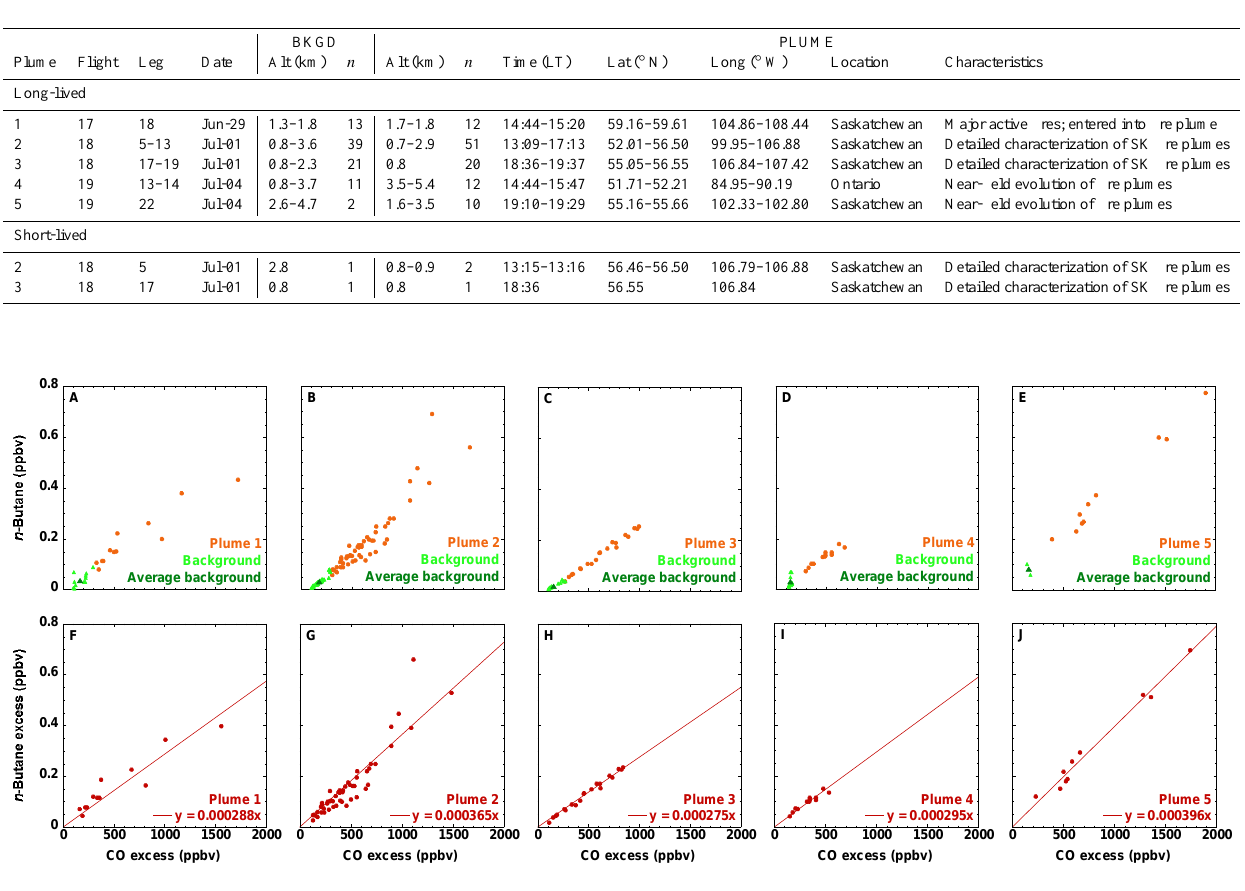
Fig. 2. Mixing ratios of n -butane versus CO in five biomass burning plumes (orange circles) and background air (light green triangles). The average background mixing ratio (dark green triangle) was subtracted from each mixing ratio measured in the biomass burning plumes to give an excess mixing ratio (red circles) for each air sample. Linear fits to the excess mixing ratios plots were forced through zero to give the emission ratio (ER) for each smoke plume. Panels (a) and (f) : Plume 1; (b) and (g) : Plume 2; (c) and (h) : Plume 3; (d) and (i) : Plume 4; (e) and (j) : Plume 5.